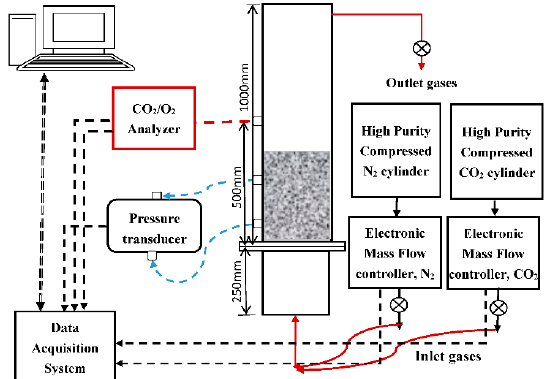
Figure 1. Schematic of the experimental setup for the CO 2 adsorption from the mixture of N 2 –CO 2 gases. Single black broken lines represent voltage signal connections of different equipment with data acquisition system (DAQ); double black broken lines represent communication of DAQ with computer.